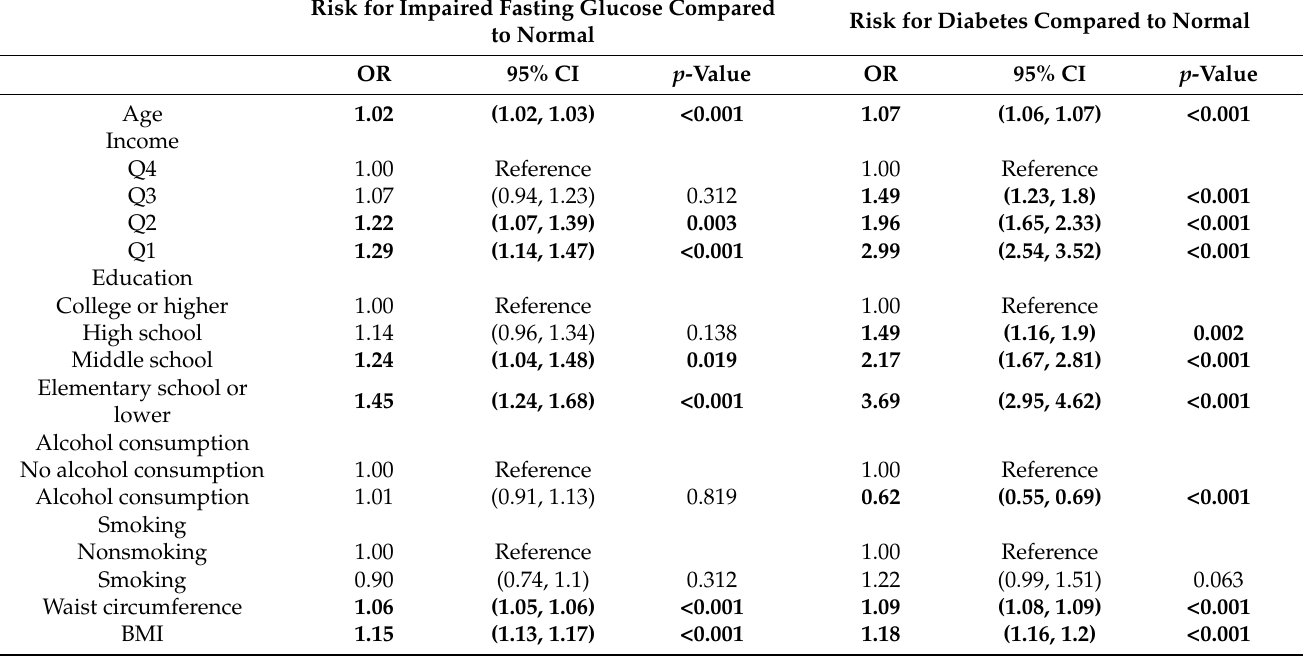
Table 2. Univariate logistic regression analysis results of risks for impaired fasting glucose and diabetes. Risk for Impaired Fasting Glucose